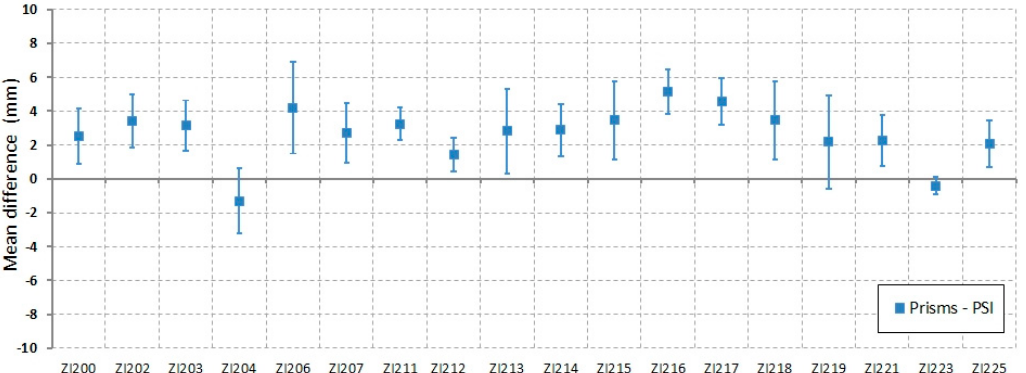
Figure 15. Mean difference and the standard deviation between the measurements of the two methods (Prisms minus PSI) for the 34 points analysed in the Sela & Tulipa dike. The Selinha dike is shown in Figure 16, with a field picture of the wall (a) and the ground displacement map of the dike and surrounding area, with the location of 8 points of field topographic measurements (b). The comparison between the topographic measurements and the PSI results are presented in Figure 17.